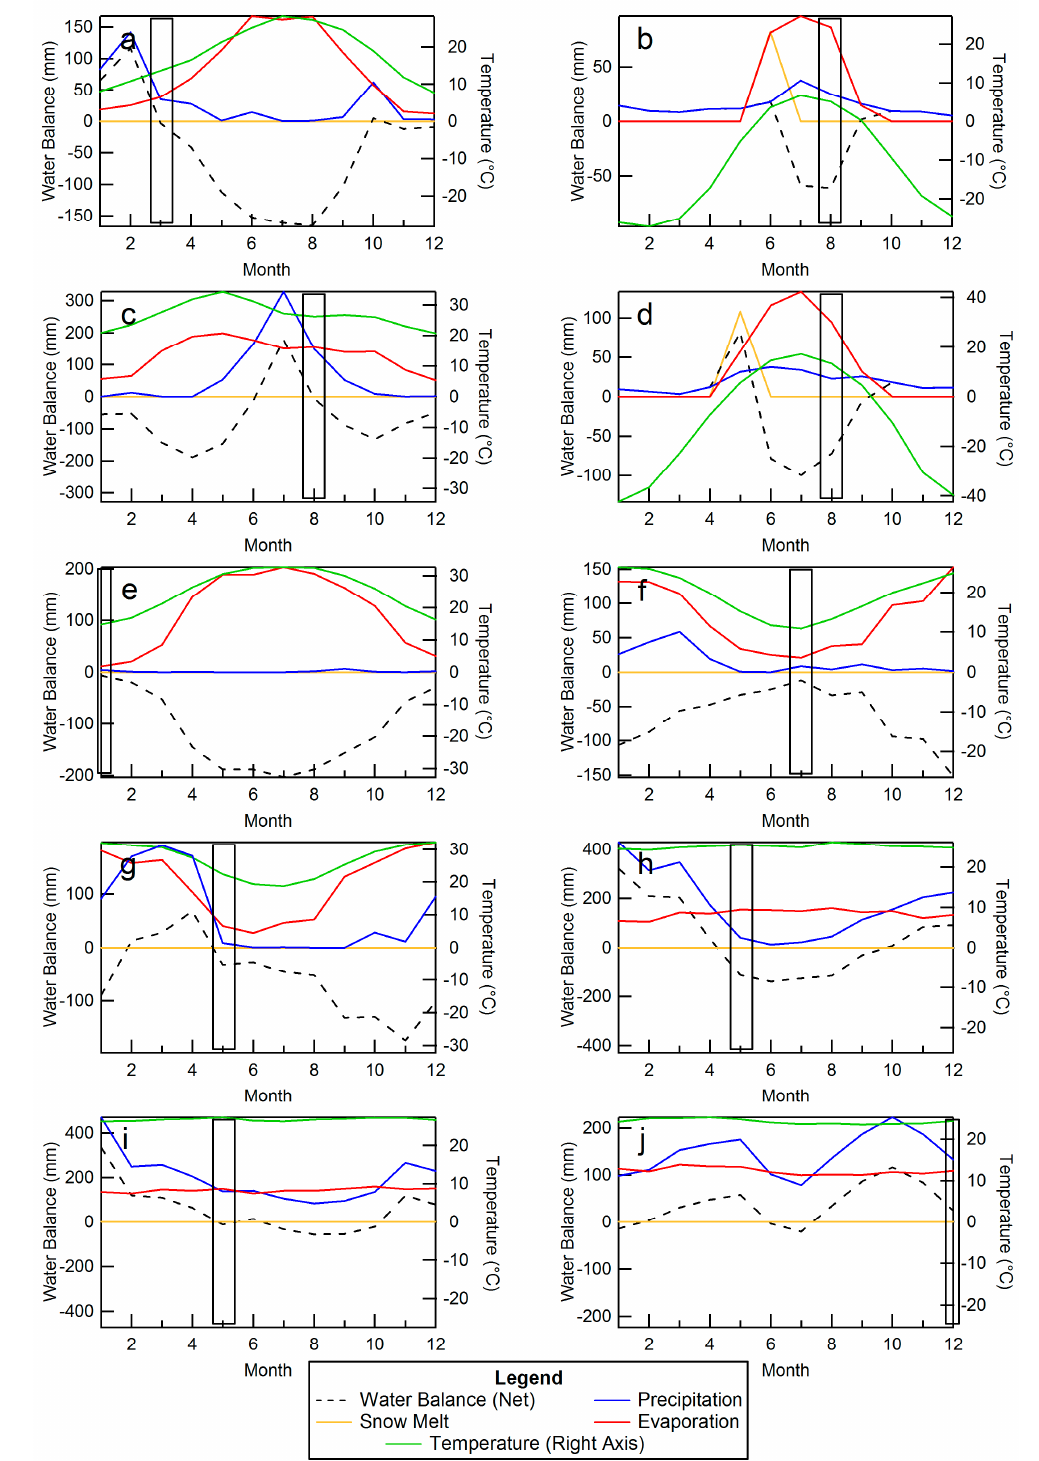
Figure 3. Simplified water budgets for nine locations around the world: ( a ) central California (37.5°N, 120.5°W); ( b ) Barrow Alaska (71.5°N, 156.5°W); ( c ) Central India (22°N, 77.5°E); ( d ) Central Siberia (63.5°N, 131°E); ( e ) Sahara Desert (26°N, 20.5°E); ( f ) South Africa (28.5°S, 19.5°E); ( g ) Western Australia (21°S, 125.5°E); ( h ) Brazilian Amazon (8°S, 56°W); ( i ) Sumatra (3.5°S, 104.5°E); and ( j ) Equatorial Africa (0°N, 18.5°E). The optimal lake surface area mapping month as selected by the LakeTime algorithm is indicated with a vertical box.